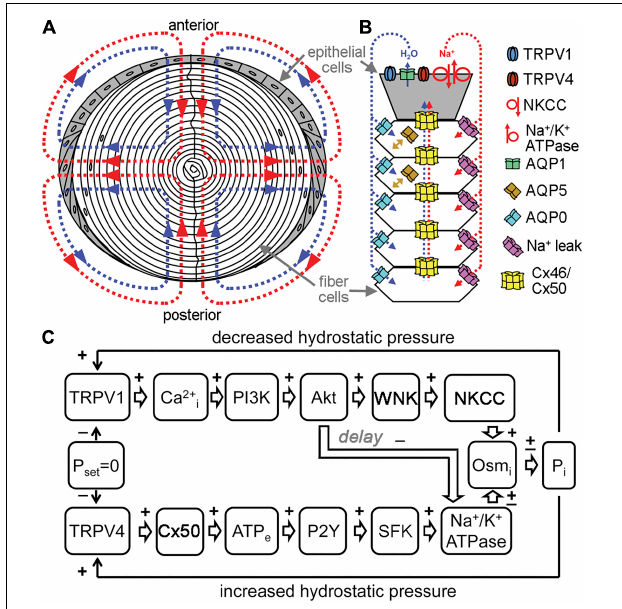
FIGURE 2 | Channels regulate lens transport. (A) The flux of Na + (red), followed by water (blue), enters the lens at both poles and exits at the equator and acts as a microcirculatory system. (B) Na + flows into the lens though extracellular spaces, moves into fiber cells through Na + leak channels, and flows back to the surface through gap junctions, where the Na + /K + -ATPase pumps it out of the lens. Water enters the lens through the extracellular spaces, moves into fiber cells through AQP0 and AQP5 driven by local osmotic gradients created by the transmembrane Na + flux, and leaves the lens through AQP1 resulting from local osmotic gradients generated by the Na + /K + -ATPase. Hydrostatic pressure drives the water from cell to cell through gap junctions. (C) A feedback control mechanism maintains hydrostatic pressure (P) and water transport in the lens. Decreased pressure activates TRPV1, which then up regulates the NKCC and down regulates the Na + /K + -ATPase through a PI3K/Akt dependent pathway. Increases in pressure activate TRPV4, which then increases Na + /K + -ATPase activity through Cx50, ATP release and purinergic receptor activation of a Src family kinase